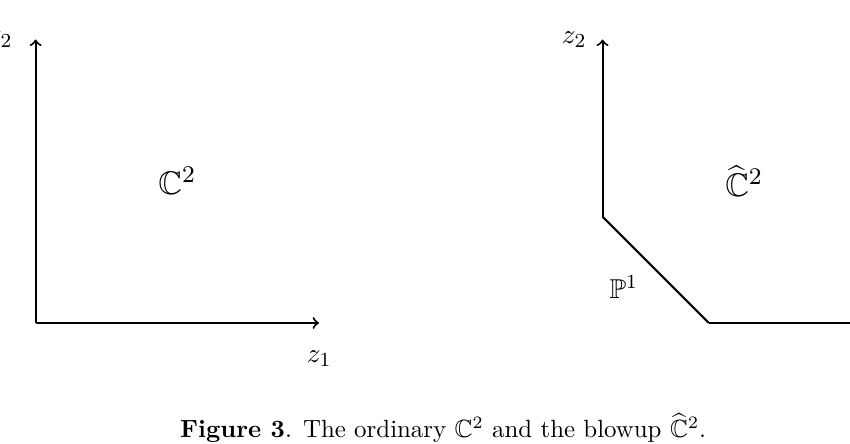
Figure 3 . The ordinary C 2 and the blowup b C 2